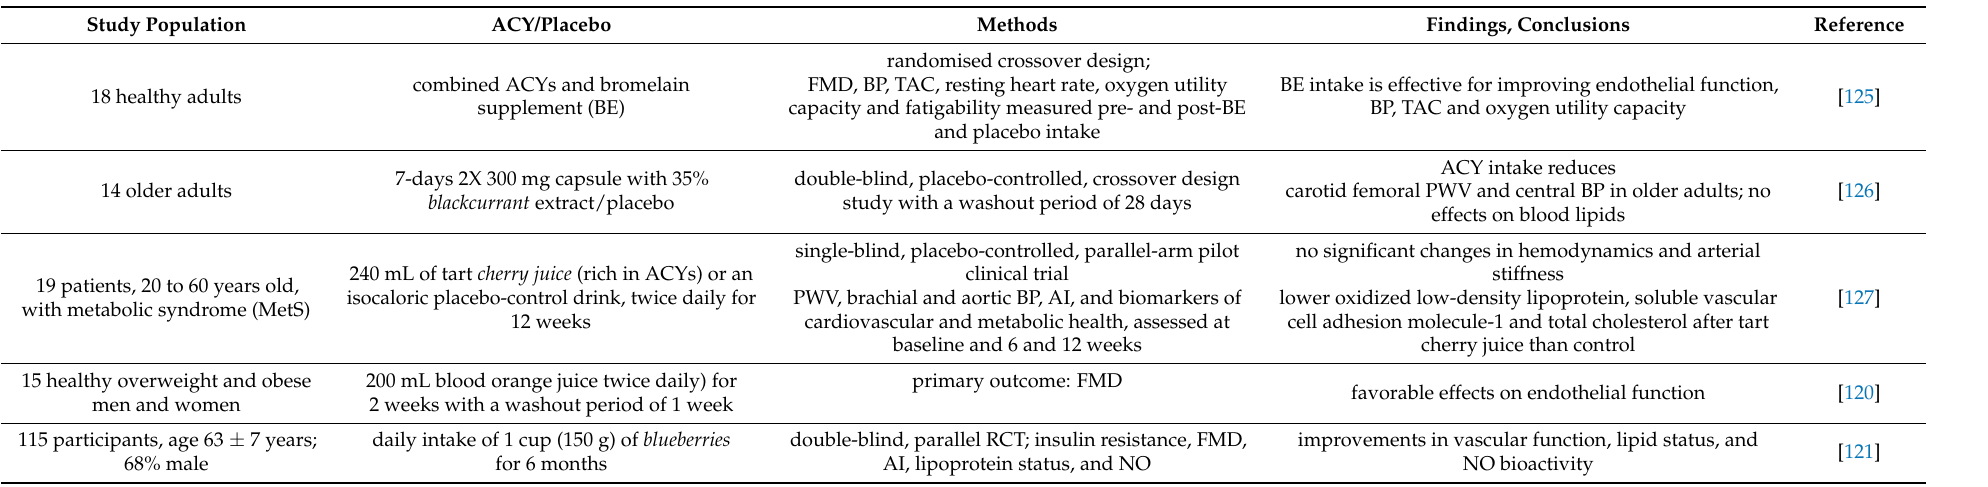
Table 4. Vascular effects of anthocyanins (ACYs). Randomized controlled trials